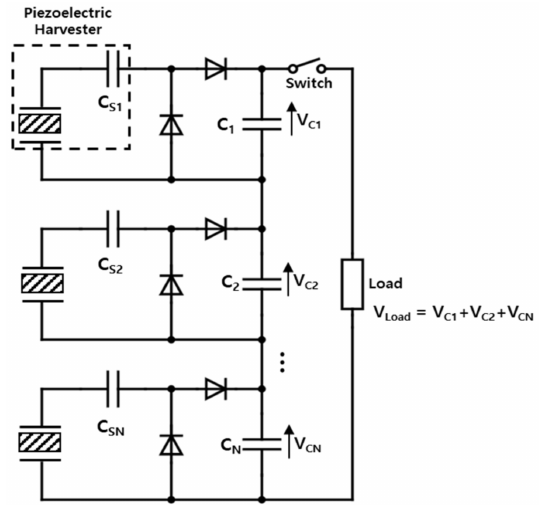
Figure A1. Example of serial connection of FTEHs and